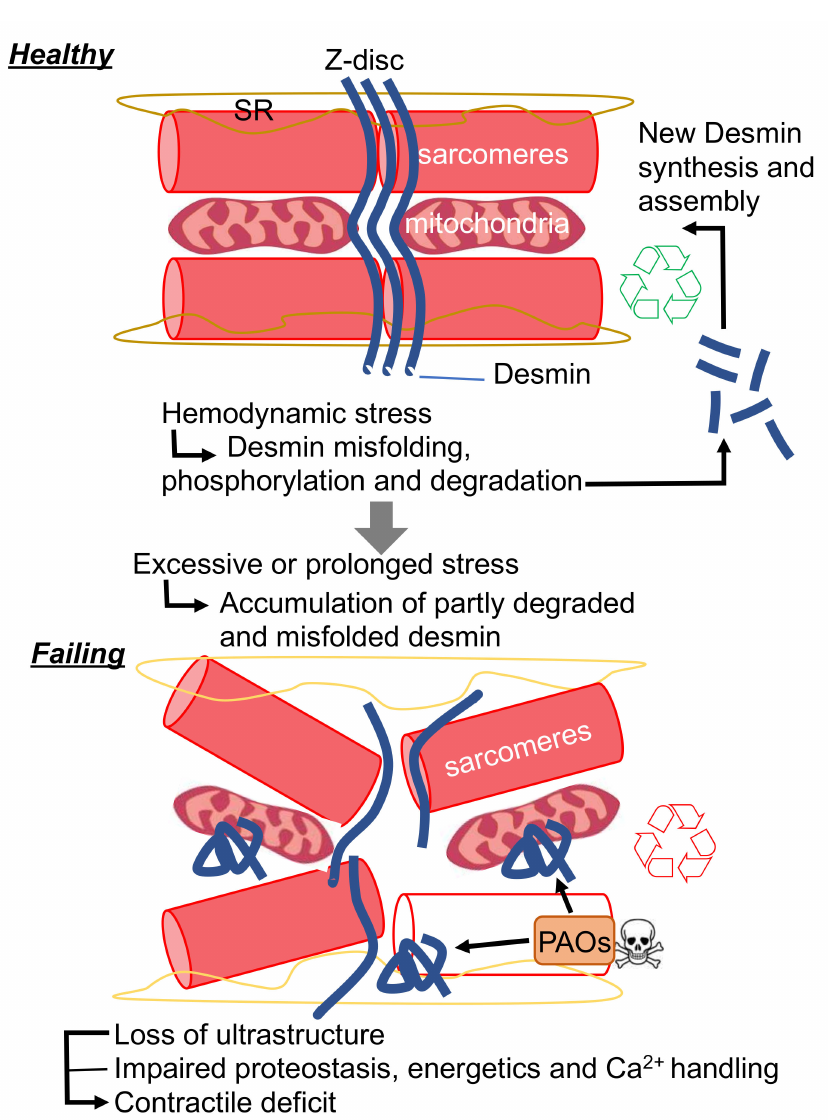
Figure 2. New proposed mechanism for desmin pathophysiological function in cardiac disease. SR, sarcoplasmic reticulum; PAOs,